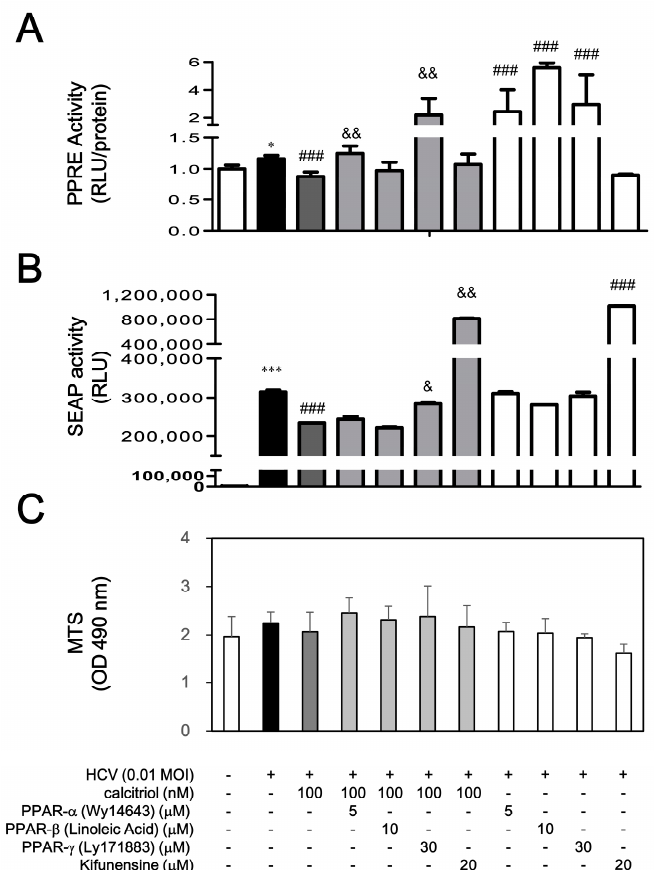
Figure 2. Effects of PPAR stimulators and ERAD inhibitor on calcitriol-mediated PPRE luciferase activity ( A ); SEAP activity ( B ) and cell viability ( C ) in HCV infection. ( A ) Cells transfected with PPREx3Luc (4 × 10 4 ) were pre-incubated with 5 µ M of Wy14643, 10 µ M of linoleic acid, 30 µ M of Ly171883, or 20 µ M of kifunensine for 1 h and treated with 100 nM of calcitriol for 6 h in a 24-well plate. reporter assay system; ( B ) HCV-infected Huh7.5-SEAP cells (8 × 10 3 ) were pre-incubated with 5 µ M of Wy14643, 10 µ M of linoleic acid, 30 µ M of Ly171883, or 20 µ M of kifunensine for 1 h and